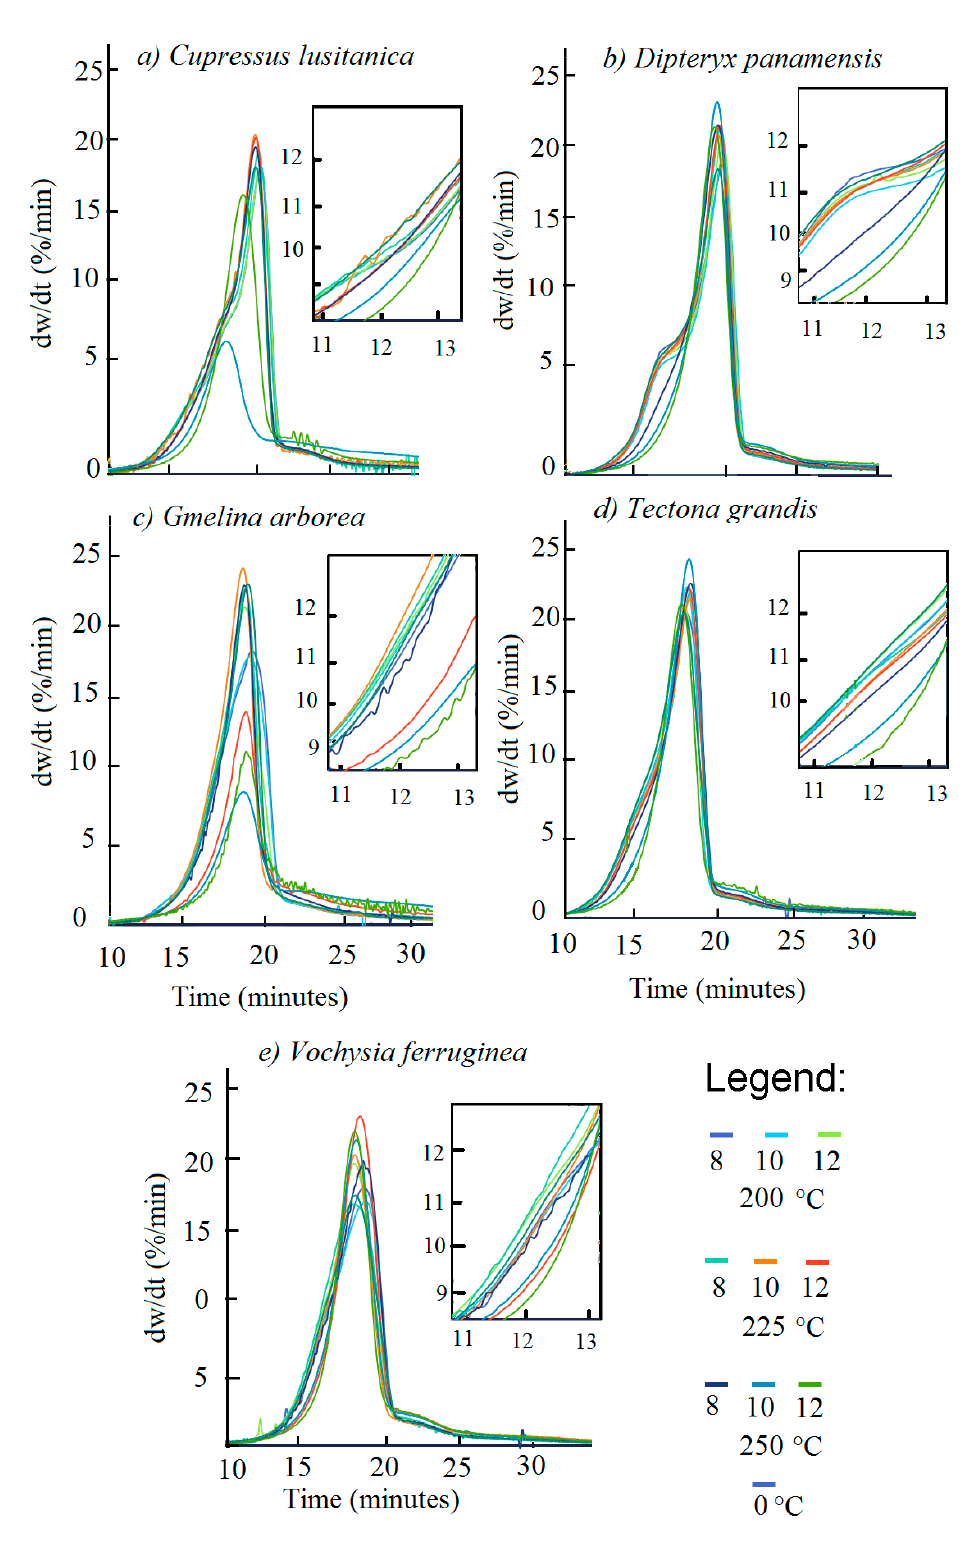
Figure 4. Devolatilization rate measured by the first derivative of the mass fraction with respect to time for the biomasses of for Cupressus lusitanica ( a ), Dipteryx panamensis ( b ), Gmelina arborea ( c ) and Tectona grandis ( d ) and Vochysia guatemalensis ( e ), torrefied at different times and temperatures. The T. grandis torrefied biomass had a D rate above 20 dw/dt, whereas torrefactions at 250-10 and 250-12 displayed no inflexion at 13 min (Figure 3d). The maximum devolatilization was reached at 17 min for the untorrefied biomass and 200 °C and 250-12 for torrefied biomass. Under other